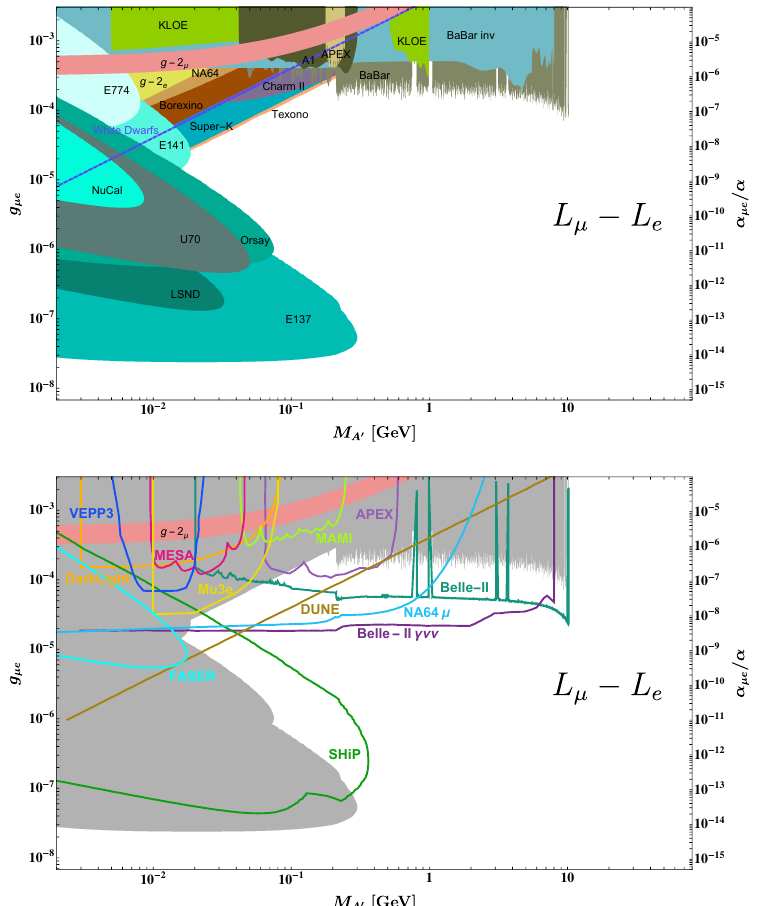
Figure 14 . Constraints from current (upper panel) and future (lower panel) experiments on a U(1) L gauge boson with gauge coupling g (cid:22) (cid:22) (cid:0) L e cooling and BBN are not shown (see sections 3.6 and